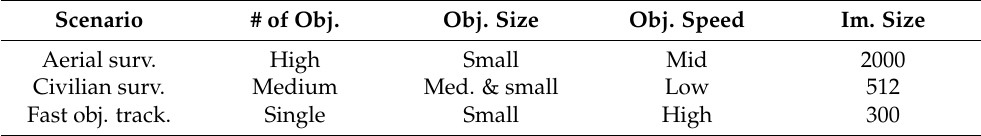
Table 1. Overview of the test scenarios considered in this work. Object size and speed are relative to the image frame. Image size is in pixels and measures the side of a squared image. Scenario # of Obj. Obj. Size Obj. Speed Im. Size Aerial surv. High Small Mid 2000 Civilian surv. Medium Med. & small Low 512 Fast obj. track. Single Small High